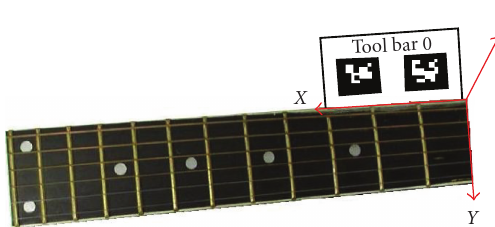
Figure 3: The world coordinate system on the top right corner of guitar